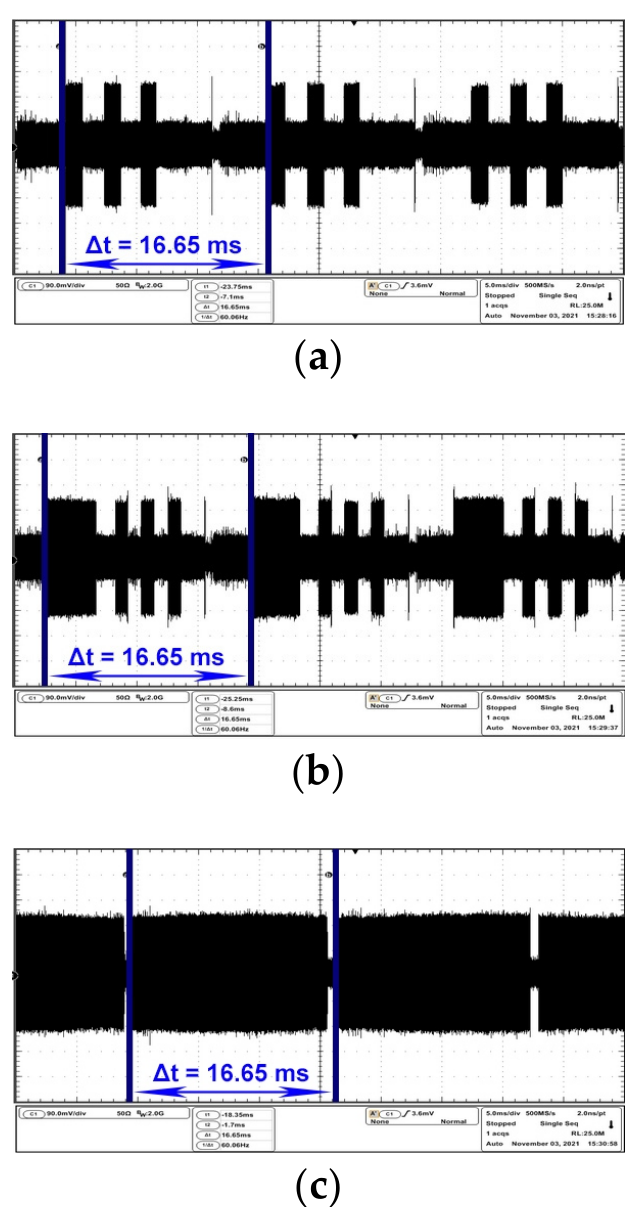
Figure 4. AOC display: ( a ) frame period corresponding to an image containing three white equal stripes on black background; ( b ) frame period corresponding to an image containing one thick white stripe and three thin white equal stripes on black background; ( c ) frame period corresponding to a white image.